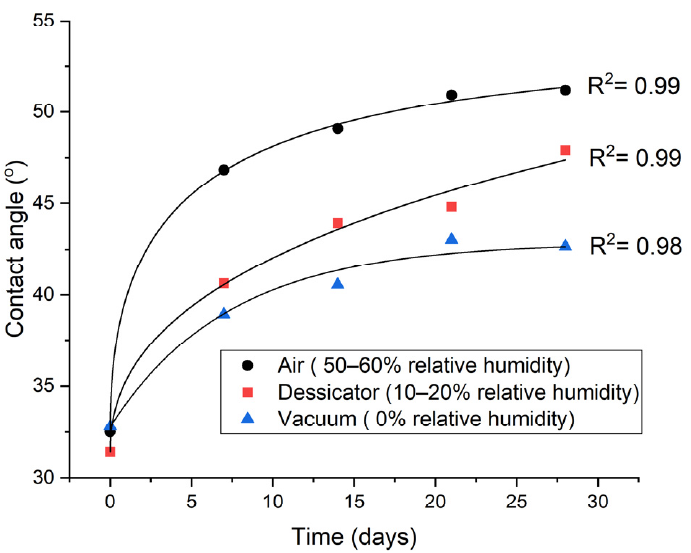
Figure 16. Ageing when store the µ Plasma treated GFPA6 at different conditions.